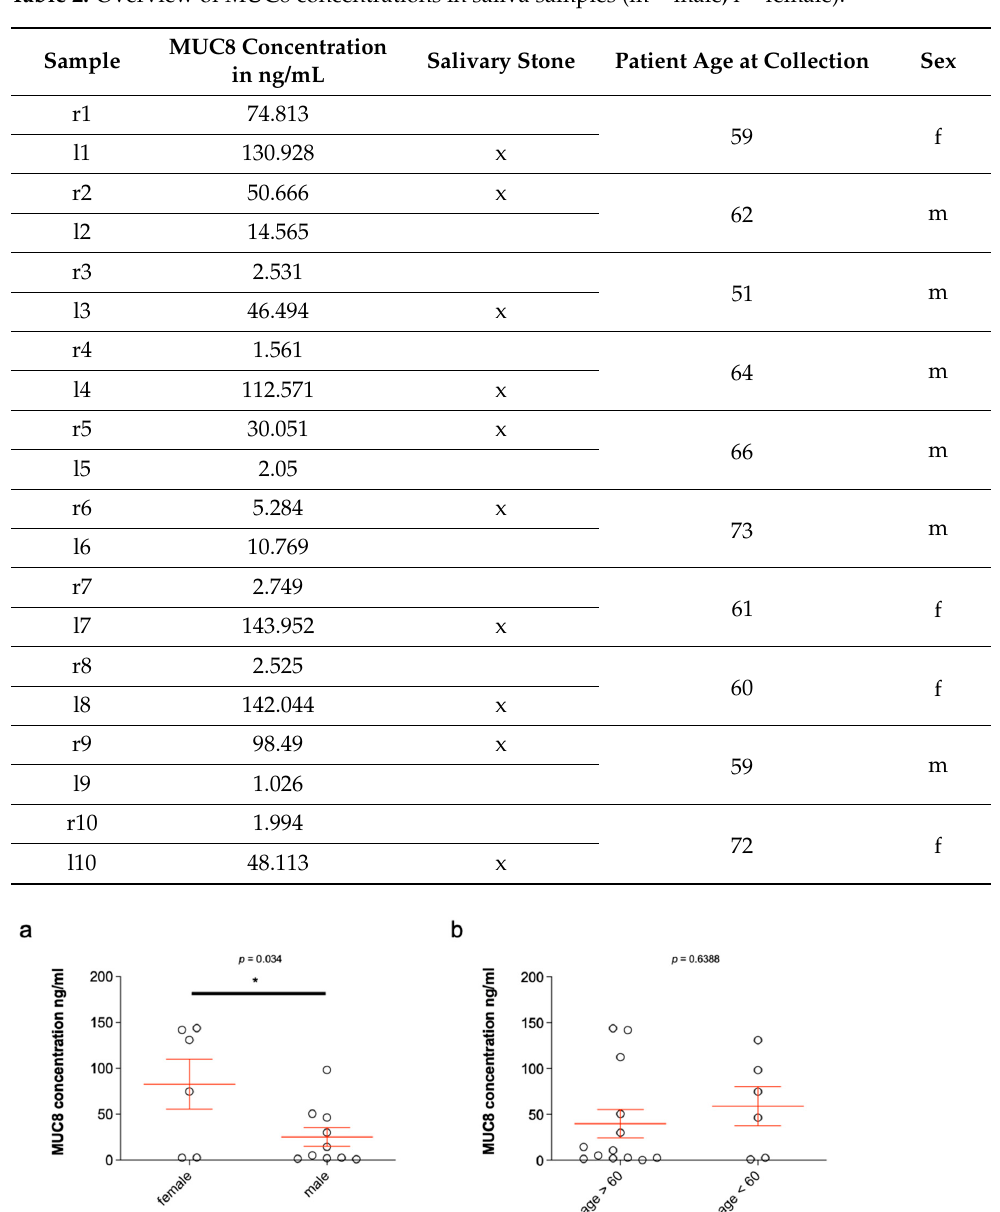
Table 2. Overview of MUC8 concentrations in saliva samples (m = male; f = female).